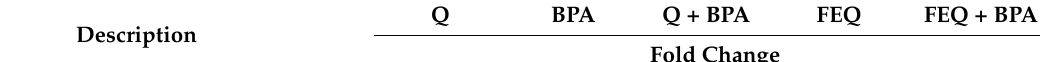
Table 2. Expression level (fold-change) of genes related to the p53 signaling pathway of HT-29